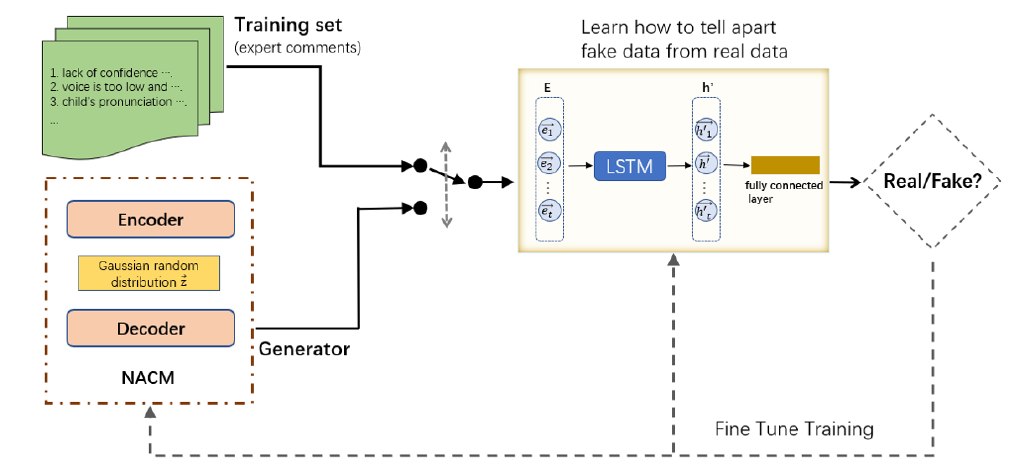
Figure 3. GAN-Based Neural Audio Caption Model. The model is divided into a generator and a discriminator. Among them, the generator follows the Neural Audio Caption Model. The discriminator uses an embedding layer, a deep LSTM layer and a fully connected